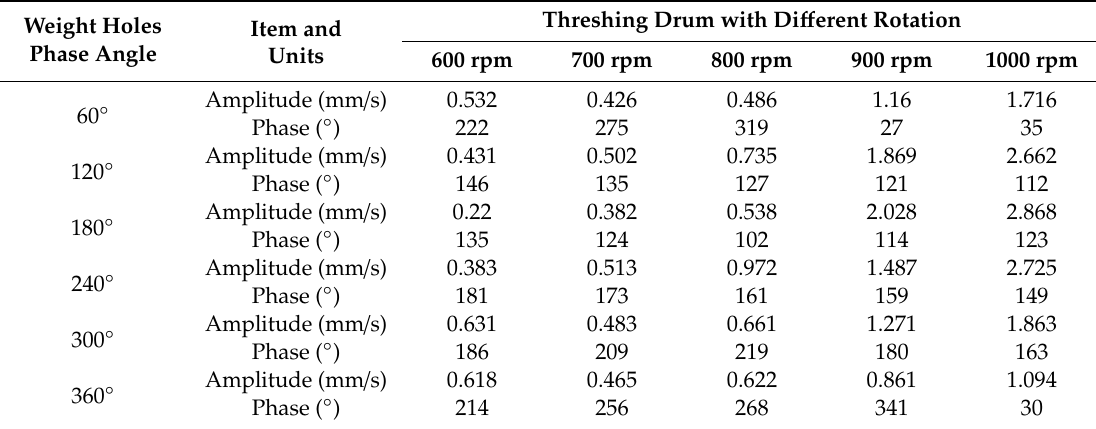
Table 3. Unbalance of each phase point with di ff erent threshing drum